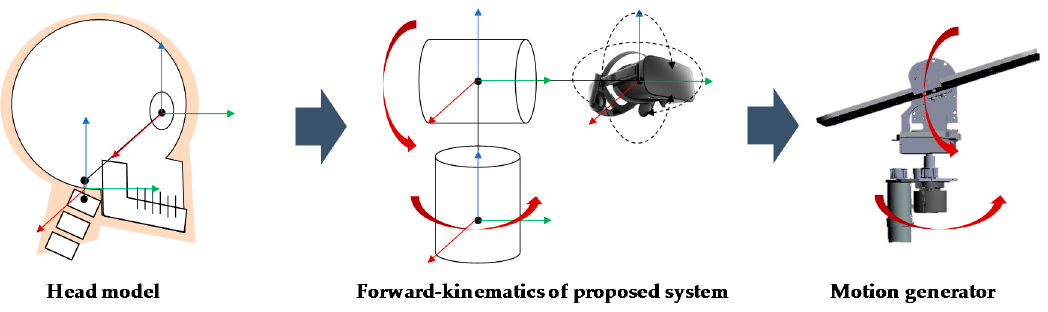
Figure 4. Kinematics of the head-model-based measurement platform.